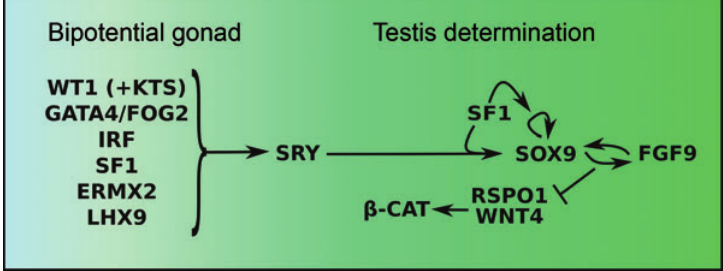
Figure 2 Genetic control of SC